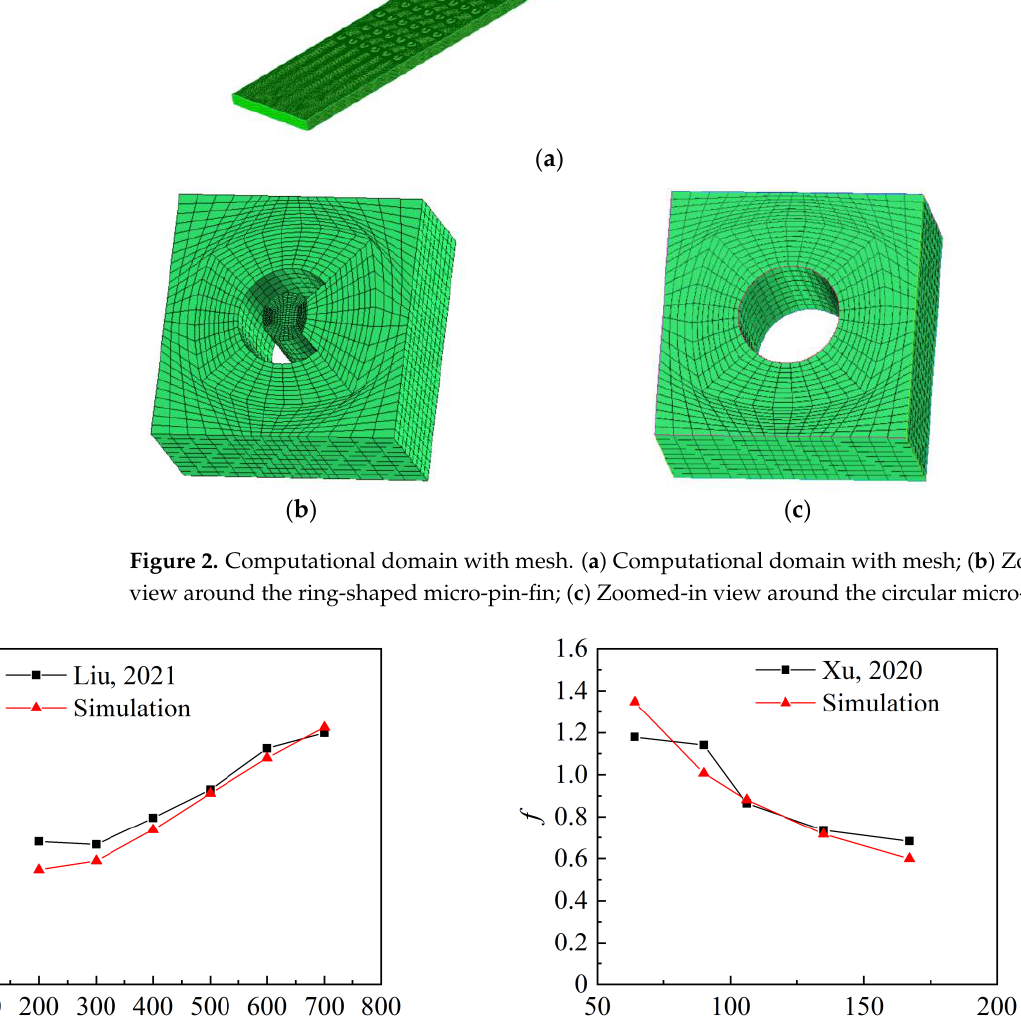
Figure 2 . Computational domain with mesh. ( a ) Computational domain with mesh; ( b ) Zoomed-in view around the ring-shaped micro-pin-fin; ( c ) Zoomed-in view around the circular micro-pin-fin.